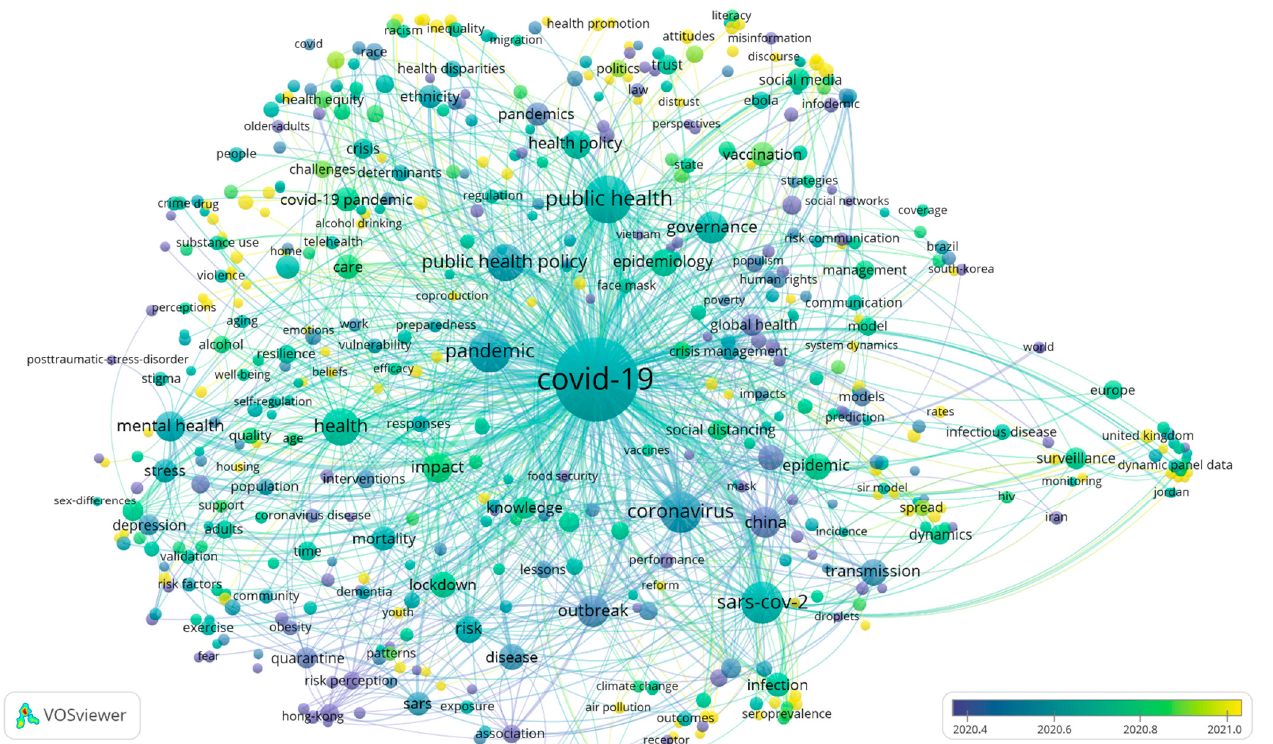
Figure 7. The cluster density visualization of the keywords’ co-occurrence network.